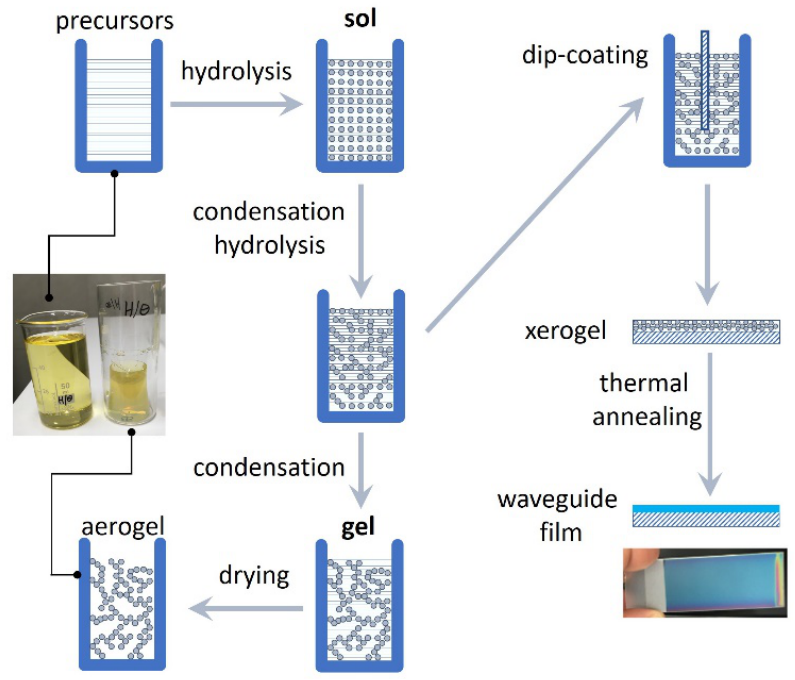
Figure 1. Schematic representation of the SiO 2 :TiO 2 WG film deposition process. In this process, tetraethyl ortotitanate (TET) is used as a titanium dioxide (TiO 2 ) precursor, and tetraethyl ortosilicate (TEOS) is used as silicon dioxide (SiO 2 ). The two precursors do not dilute in water; therefore, the ethyl alcohol (C 2 H 5 OH) is used as the homogenizing factor. Hydrolysis and condensation reactions are catalyzed with the use of hydrochloric